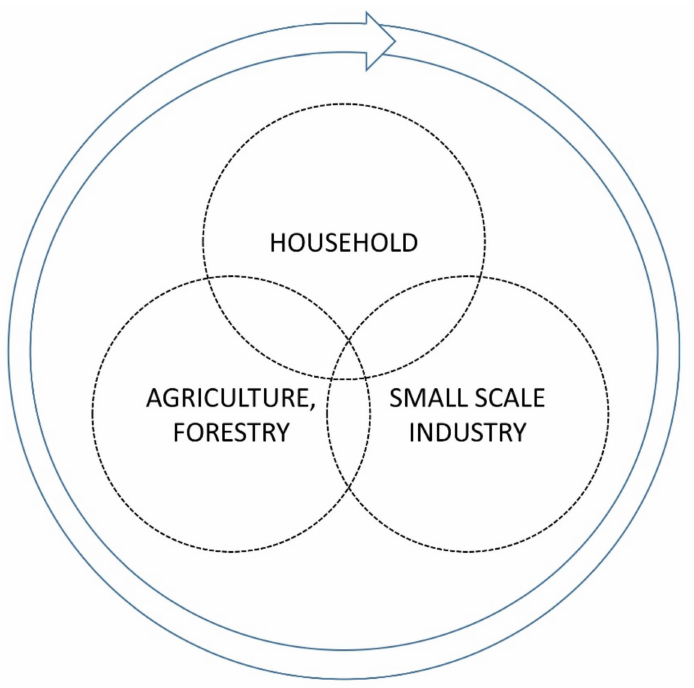
Figure 6. Main activities related to the cyclical energy use of organic